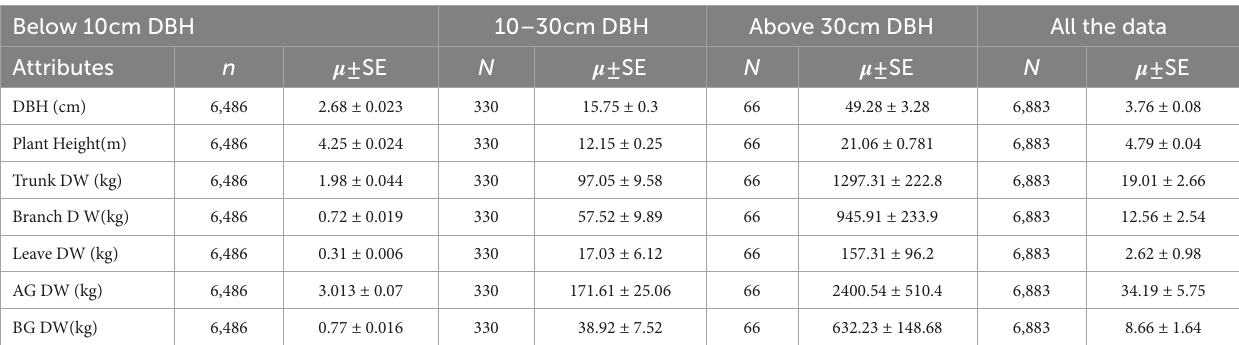
TABLE 2 Forest attributes for the entire data stratified based on